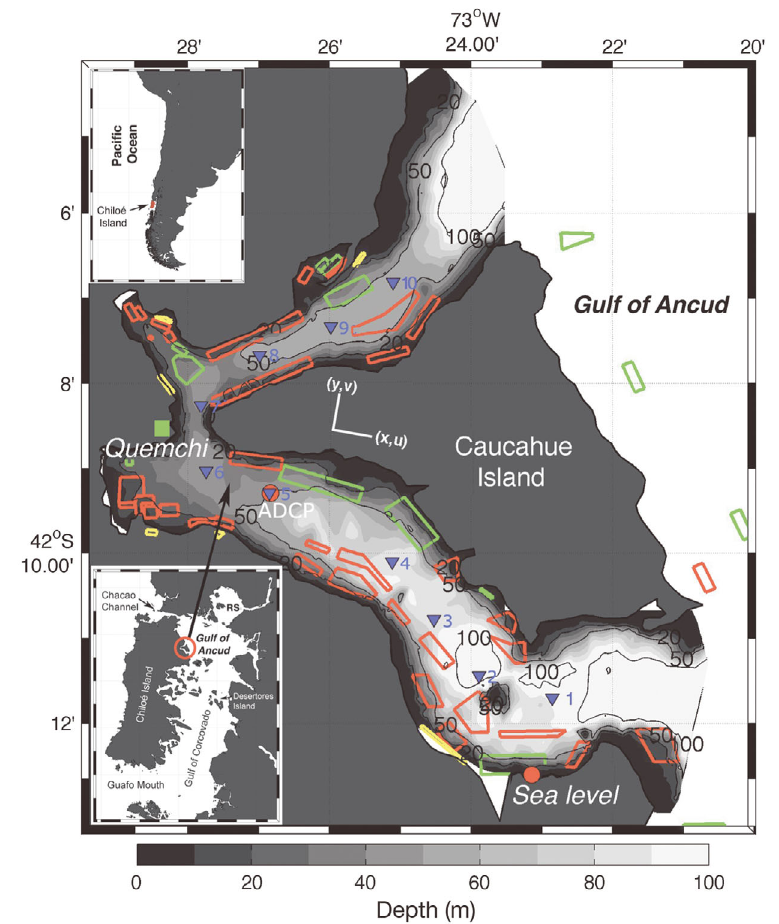
Fig. 1. Upper inset shows the Chiloe Inland Sea (CIS) located on the west side of the Southern Cone of South America. Lower inset shows the CIS, extended from Reloncavi Sound (RS) to the Guafo Mouth. Red circle highlights the Caucahue Channel located on the west side of the Gulf of Ancud. Amplified box shows the Caucahue Channel with the location of the acoustic Doppler current profiler (ADCP, 300 kHz) between 17 April and 21 July 2011. Red points show the ADCP and tide gauge locations, and blue triangles indicate hydrographical stations. Green, red and yellow boxes indicate the location of salmon, shellfish and seaweed production centers,